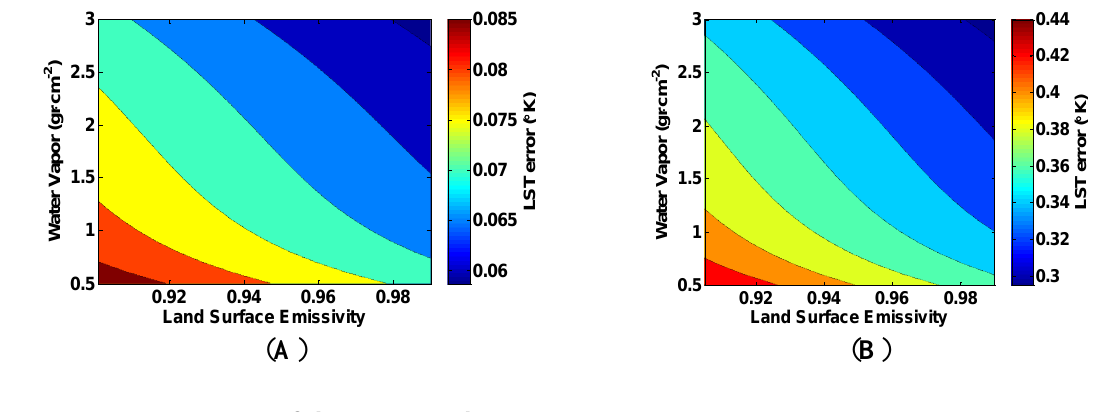
– T is kept constant at 1 °K, and T 10 11